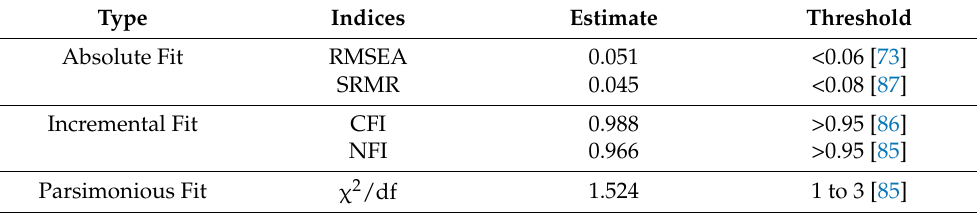
Table 7. Structural equation model fit estimates.